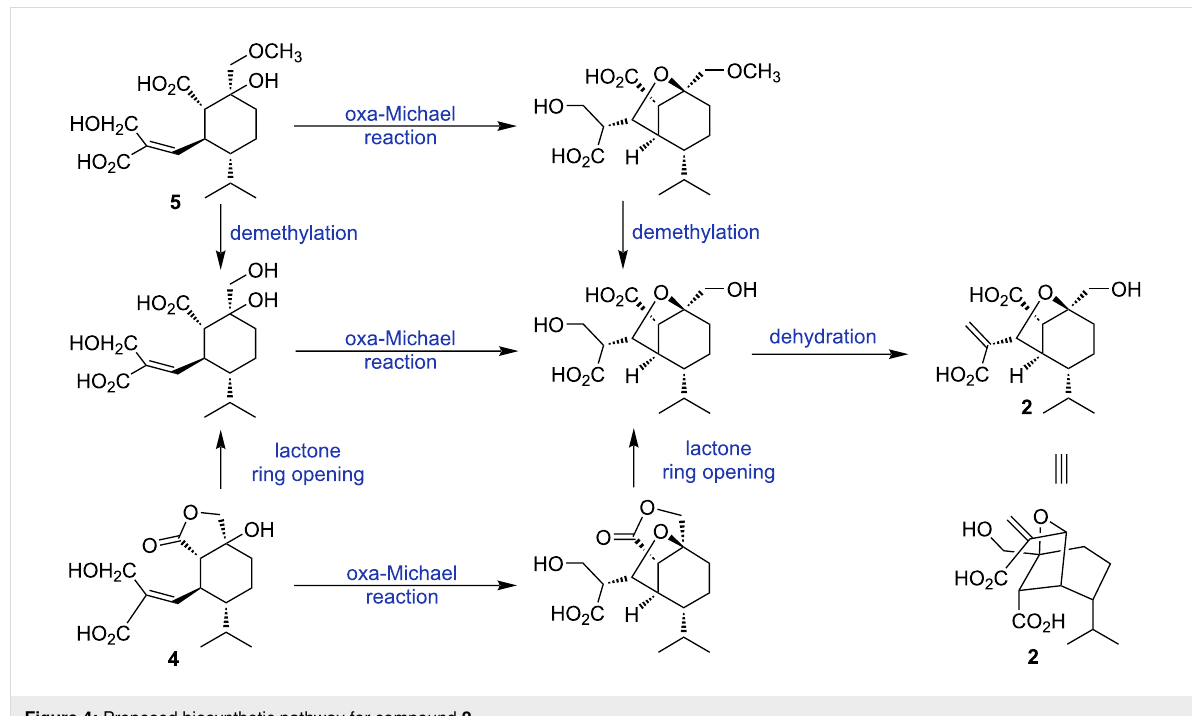
Figure 4: Proposed biosynthetic pathway for compound 2